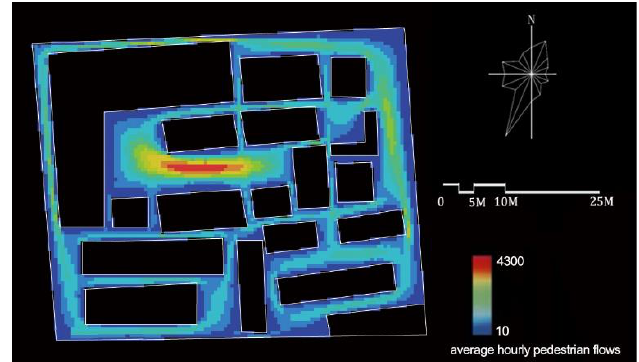
Figure 8. Integration of pedestrian flow simulation on VGA.